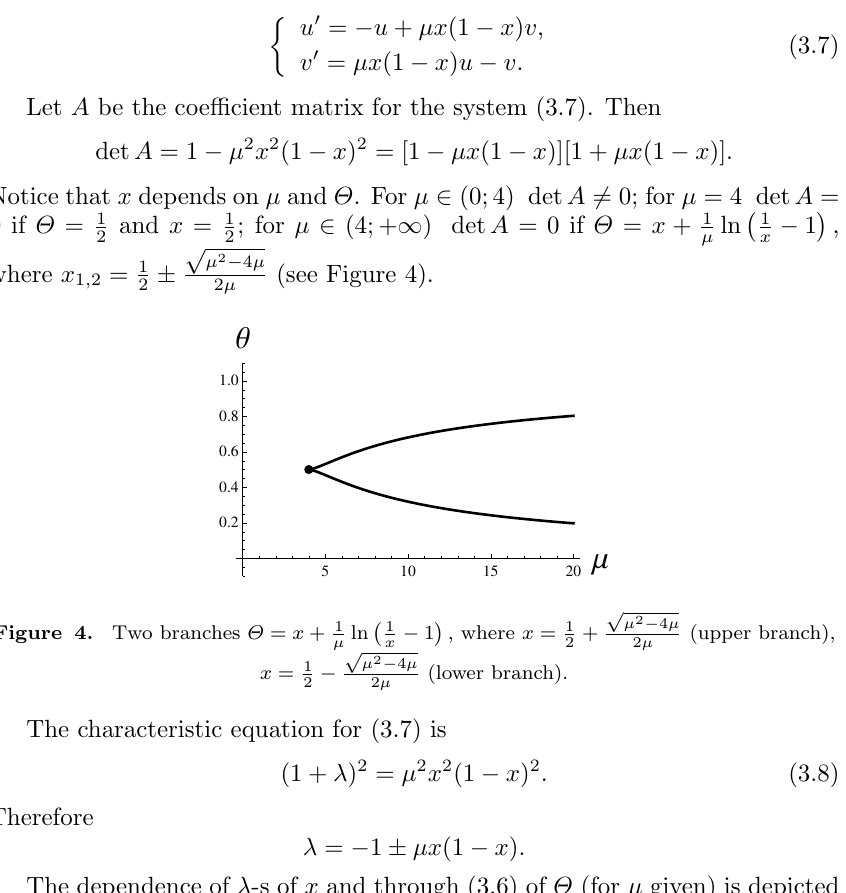
ln (cid:0) 1 − 1 (cid:1) , where x = 1 µ x